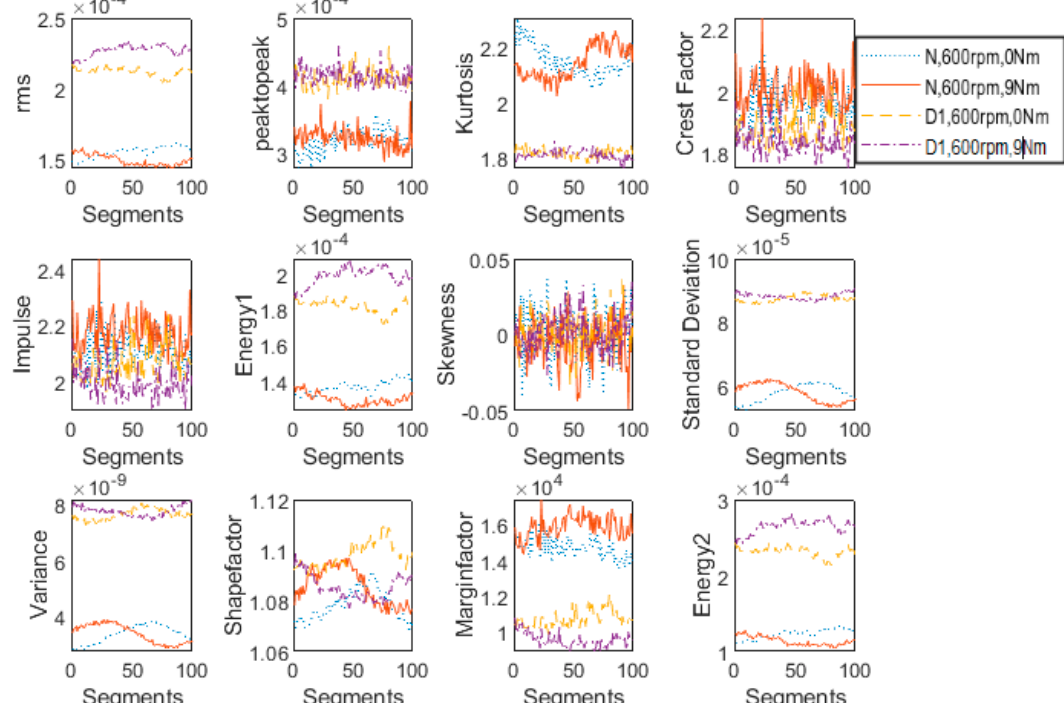
Figure 5. Features’ plot for normal and 1 tooth broken gear boxes at constant speed (600 rpm) and changing load (0 Nm and 9 Nm).